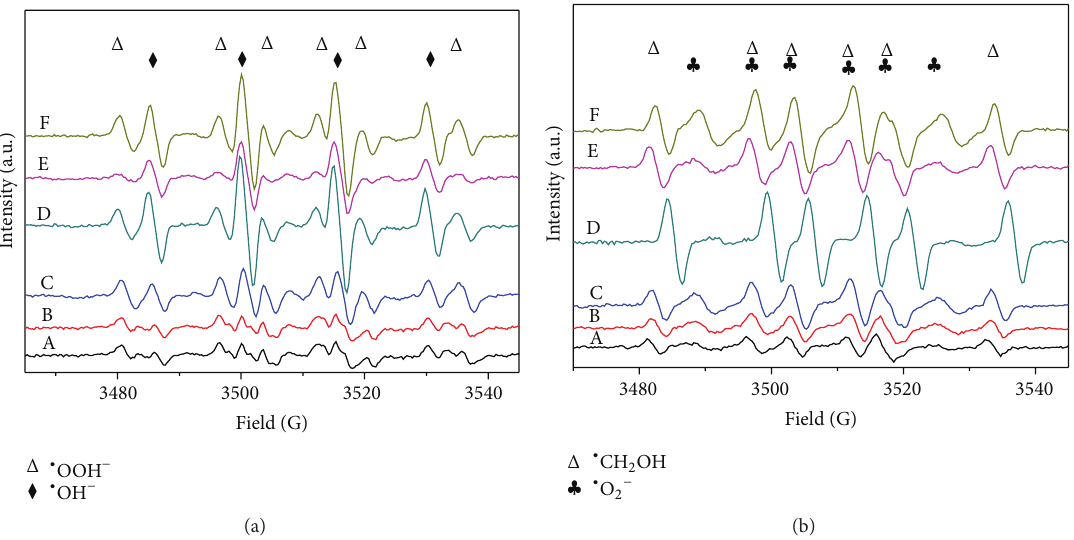
Figure 8: DMPO spin-trapping ESR spectra of (A) TiO 2 , (B) SO 42− /TiO 2 , (C) SO 42− /Ag-TiO 2 , (D) SO 42− /Au-TiO 2 , (E) SO 42− /Rh-TiO 2 , and (F) SO 42− /Pt-TiO 2 samples, at ambient temperature in an aqueous dispersion for (a) DMPO- ∙ OH and in a methanol dispersion for (b) 2− DMPO- ∙ O